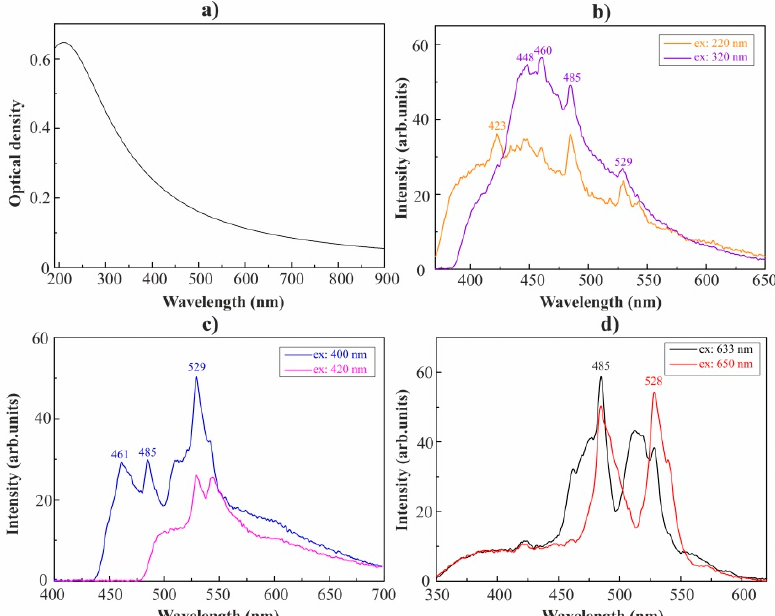
Figure 4. ( a ) Extinction spectrum of the HP-HT nanodiamond film with a thickness of 0.5 μ m; ( b ) the luminescence spectra of the aqueous HP-HT nanodiamond suspension with concentration of 0.02 wt.% when excited by radiation at wavelengths of ( b ) 220 and 320 nm, ( c ) 400 and 420 nm; and, ( d ) the up-conversion luminescence spectra of aqueous HP-HT nanodiamond suspension with a concentration of 0.02 wt% when excited by radiation at wavelengths of 633 and 650 nm.